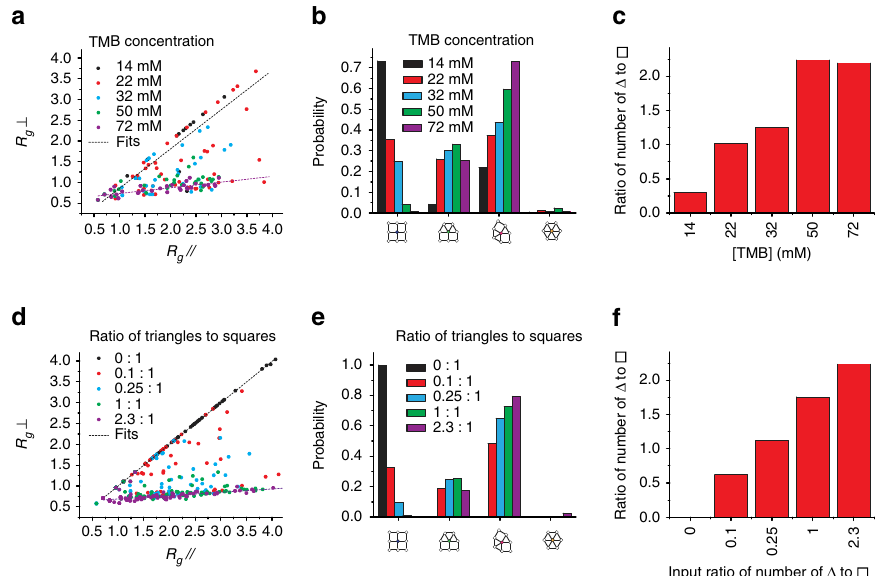
Fig. 4 Analysis of TMOS/APTMS-derived MSNs and simulated structures. a Plot of R g in perpendicular vs. parallel space, calculated for MSNs synthesized from fi ve different mesitylene (TMB) concentrations. b Distribution of pore conformers (4 4 , 3 3 4 2 , 3 2 4 1 3 1 4 1 , and 3 6 ) calculated for particles synthesized from fi ve different TMB concentrations. c Ratio of triangle to square tiles calculated for particles in a . d – f Plots corresponding to a – c for 500 particles derived from simulations with fi ve different triangle to square ratios NATURE COMMUNICATIONS | 8: 252 | DOI: 10.1038/s41467-017-00351-8 |